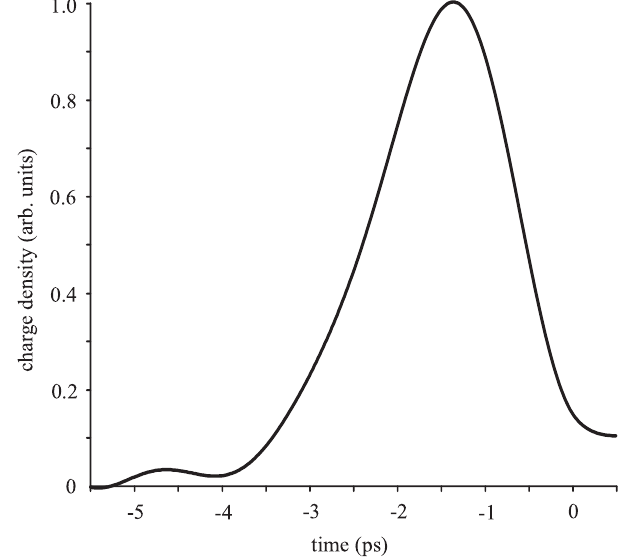
FIG. 9. Measured bunch profile with most of the charge con- centrated in one peak. Data taken on 13/07/07, between 0451– 0527. The number of electrons per bunch was ffi 1 : 2 (cid:2) 10 10 .